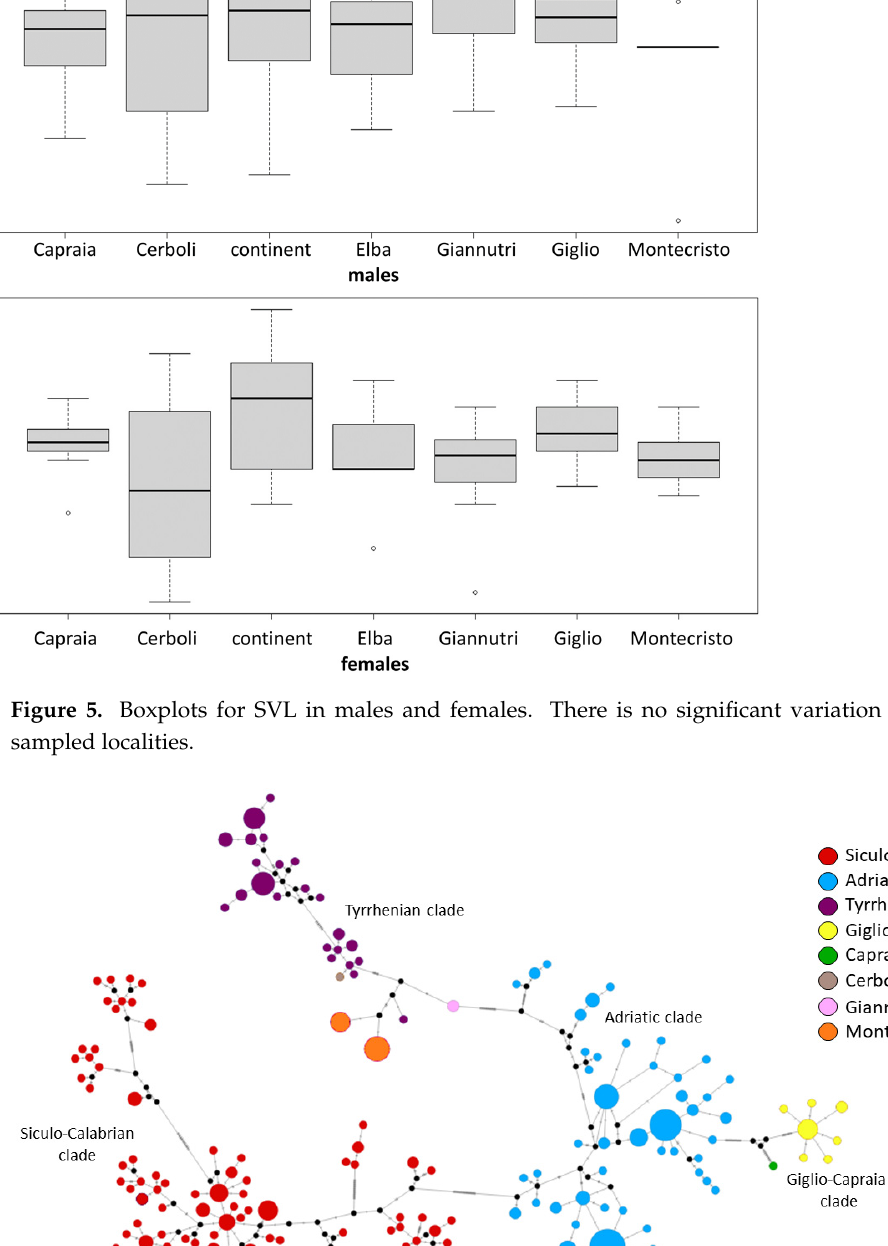
Table 4. Mean p-distances between Podarcis siculus populations of the Tuscan Archipelago and